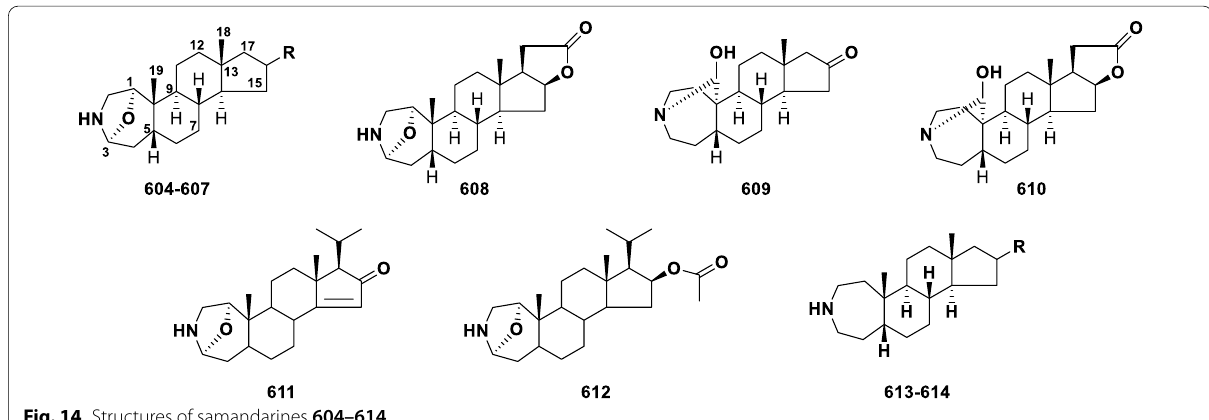
Fig. 14 Structures of samandarines 604–614